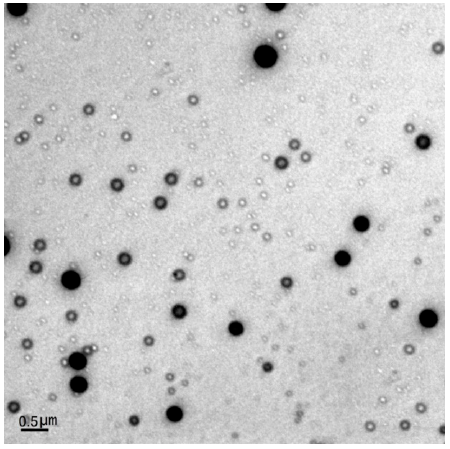
Figure 4. TEM image of DCT ‐ loaded T f ‐ conjugated PLGA NPs.